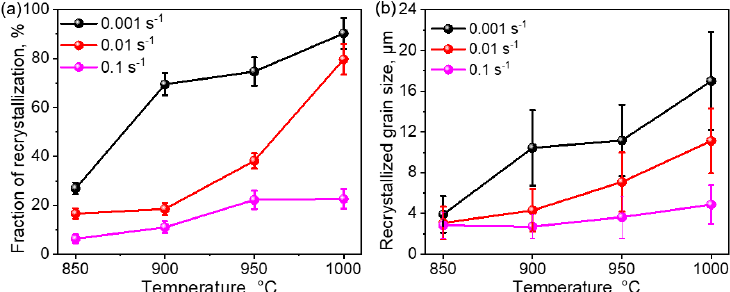
Figure 10. The volume fraction ( a ) and average grain size ( b ) of the recrystallized grains in the CoCrNi alloy hot-compressed to a true strain of 1.0. The compression temperature is 850, 900, 950, and 1000 ◦ C, and the strain rate is 0.001, 0.01, and 0.1 s − 1 .